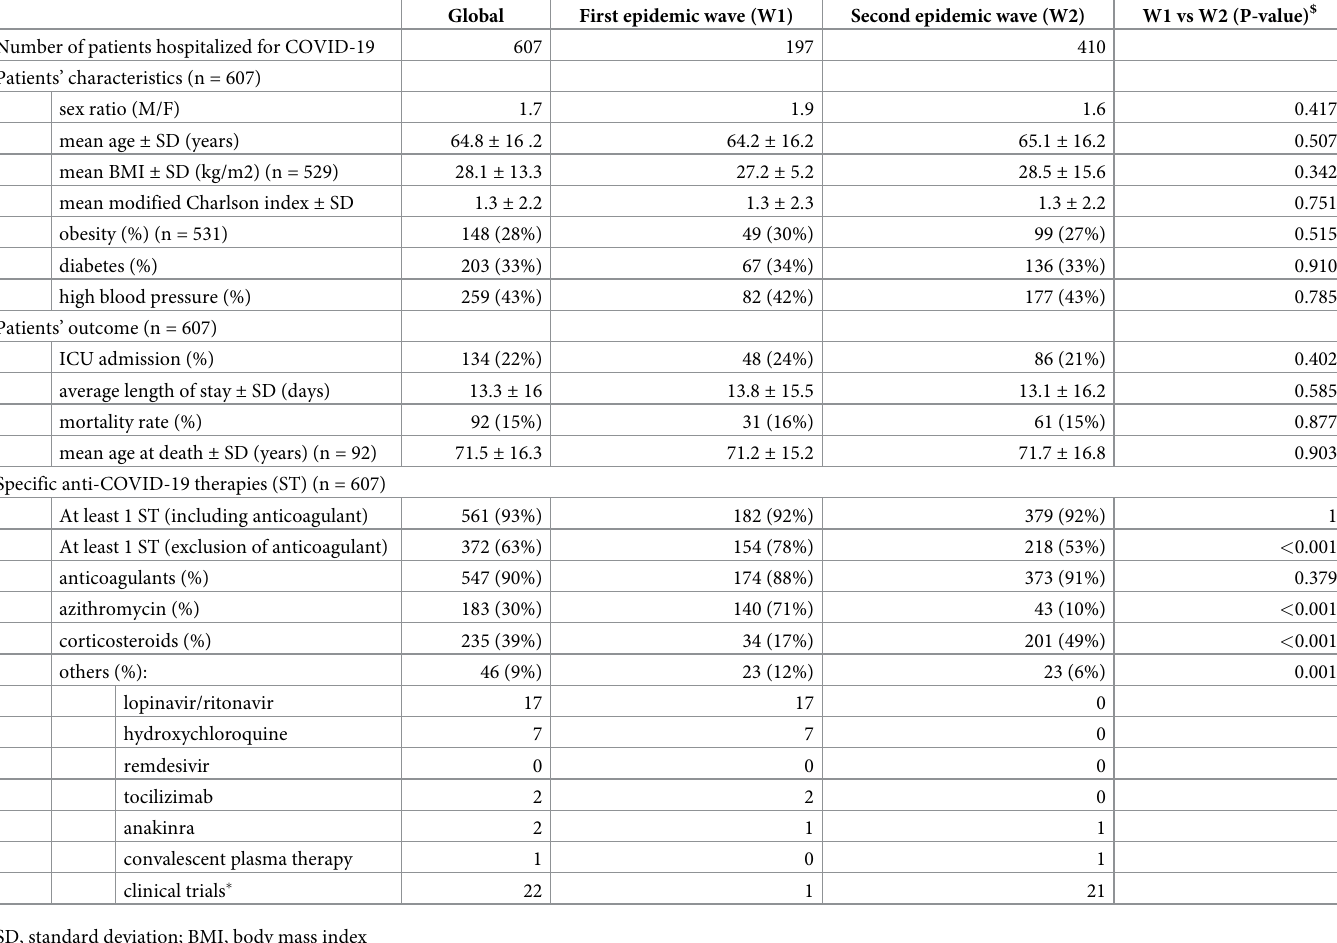
Table 1. Characteristics and outcome of patients hospitalized with COVID-19, and specific therapies administered during the first (V1) and second (V2) epidemic